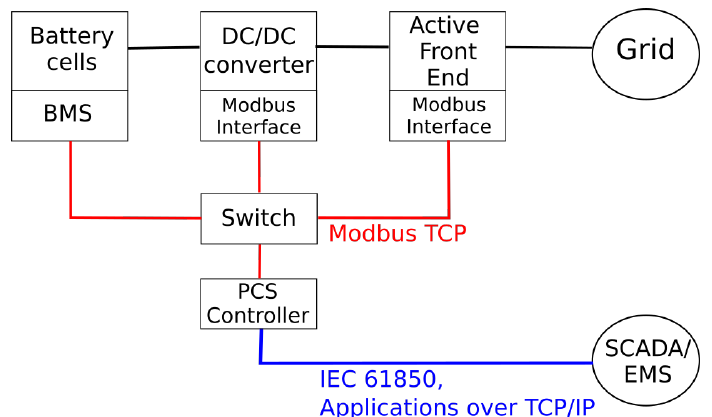
Figure 1. Typical architecture of a BESS within a smart